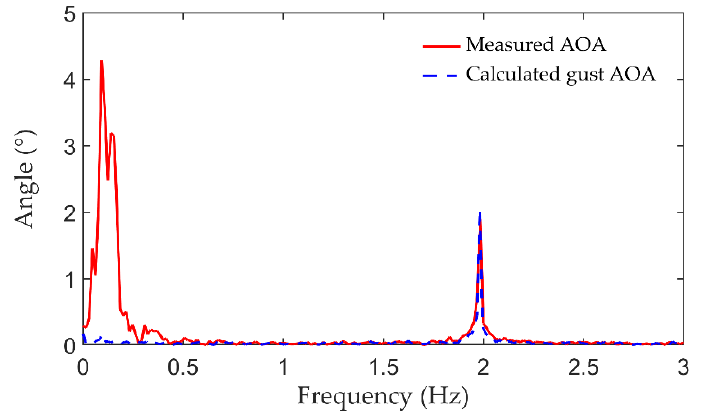
Figure 11. Spectrum analysis of the gust calculation.